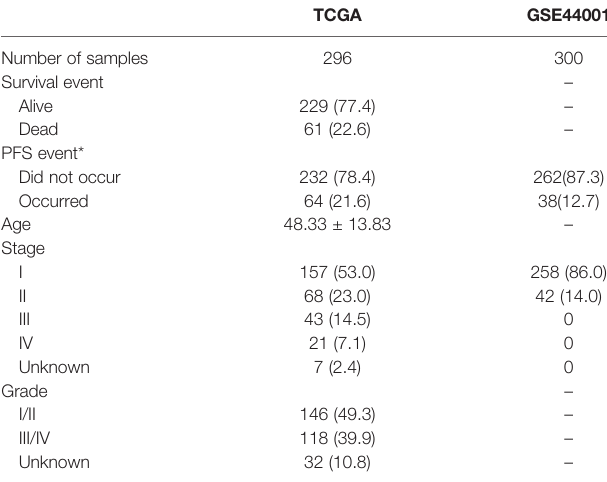
TABLE 1 | Clinical characteristics of cervical cancer patients.